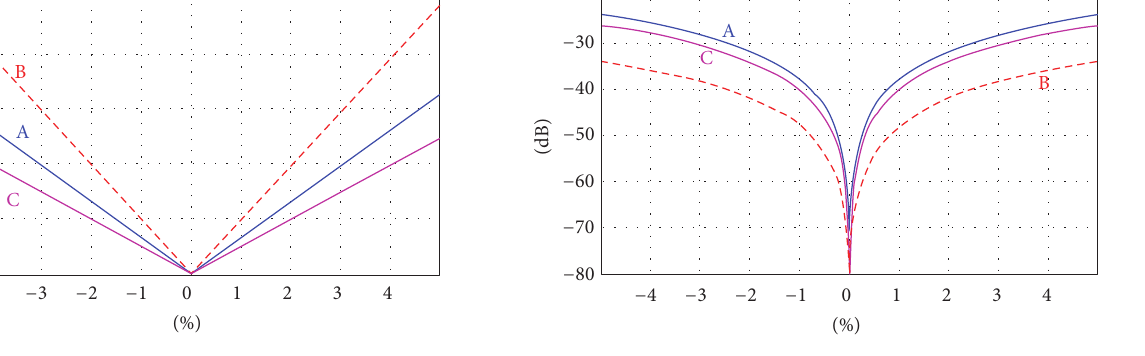
Figure 19: 𝐹( Z 𝑈 ) at the tuning frequency, versus a relative capaci- Figure 20: 𝐹( Z 𝑈 ) in dB at the tuning frequency, versus a relative tance variation of a single adjustable impedance device contributing capacitance variation of a single adjustable impedance device con- to C 𝑈 : curve A if its initial value is 𝐶 𝑈𝐺 ; curve B if its initial value is tributing to C 𝐴 : curve A if its initial value is 𝐶 𝐴𝐺 ; curve B if its initial 𝐶 𝐶 value is 𝐶 𝐴𝑁 ; curve C if its initial value is 𝐶 𝐴𝐹 . 𝑈𝑁 ; curve C if its initial value is 𝑈𝐹 .